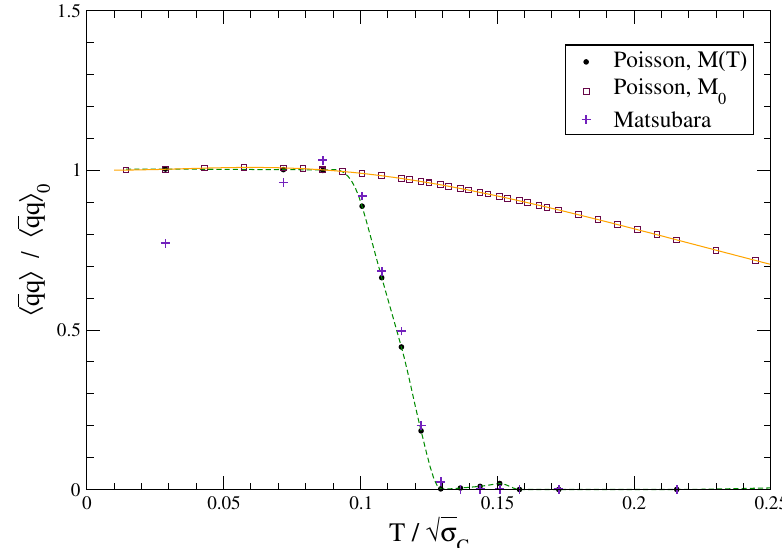
Figure 8. The quark condensate as function of the temperature calculated from the zero- and finite-temperature solutions of the quark gap